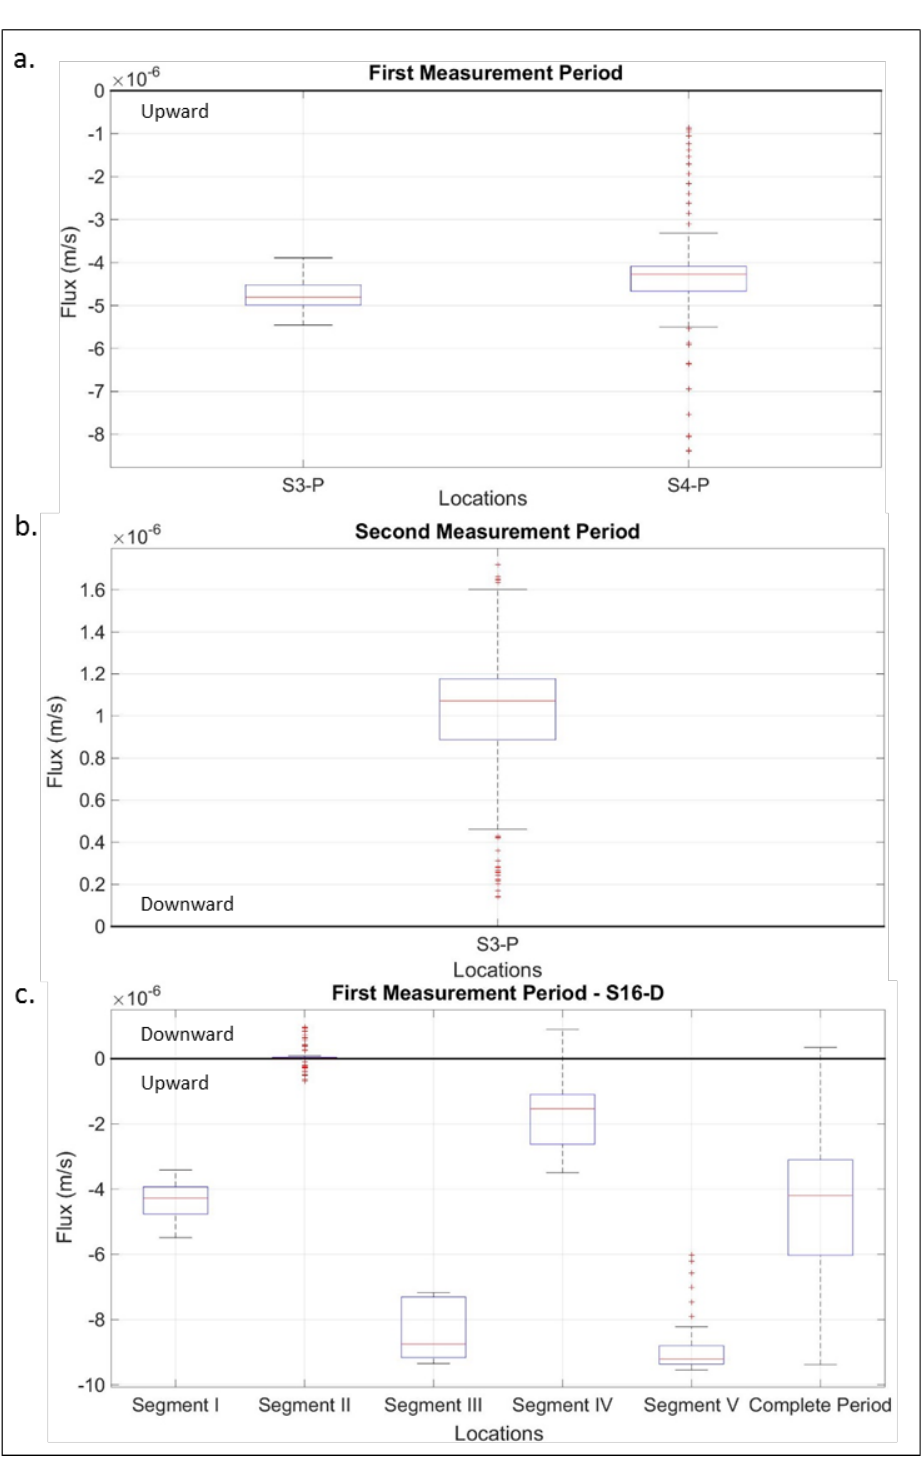
Figure 9. Box-plots summarizing vertical flux values calculated ( a ) for sites S3-P and S4-P during 16–25 March 2015 period; ( b ) for site S3-P during 12 July–2 August 2015; and ( c ) for site S16-D during 16 March–27 April 2015 period. Note that time segments indicating reservoir operation periods are shown in Figure 8b.